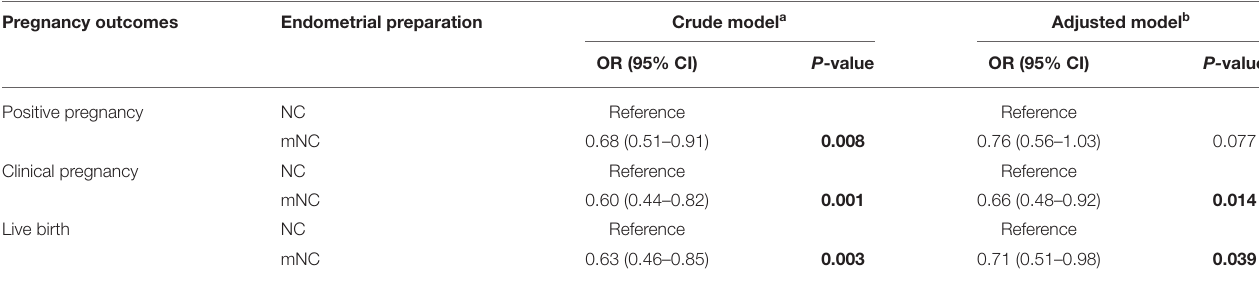
TABLE 3 | Relationship between endometrial preparation and pregnancy outcomes in different